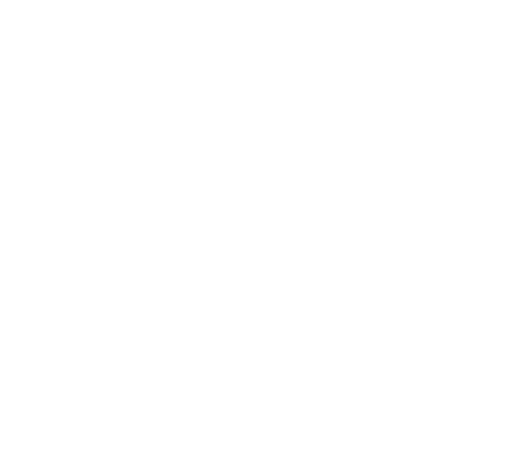
Figure 1. Effect of different DESs on AMP extraction. The extraction conditions were as follows: DESs concentration was 80 wt%, liquid–solid ratio was 30:1, pH was not adjusted, the extraction temperature was 60 °C, and the extraction time was 60 min.